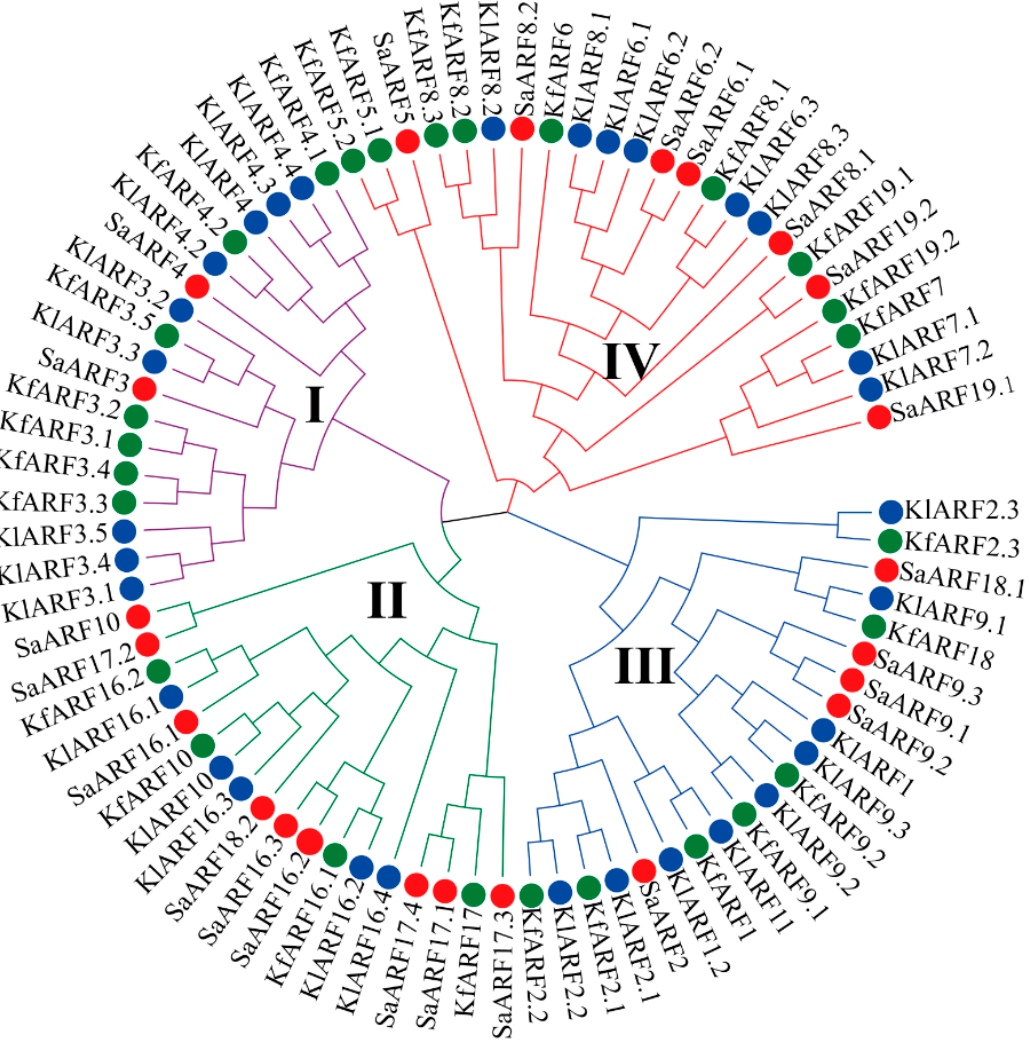
Figure 6. Phylogenetic analysis of ARFs among three Crassulaceae plants. I, II, III, IV indicated the first class to the fourth class in the figure . The circles with same color indicated the ARFs were in the same species. Green circle, K. fedtschenkoi ; red circle, HE; blue circle, K. laxiflora . Table 1. Positive selection sites in each clade.